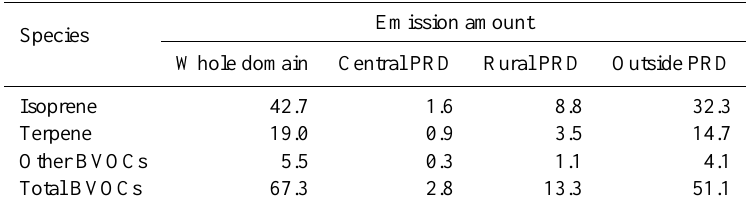
Table 2. Amount of BVOC emissions (10 3 ton) during the simulated period.